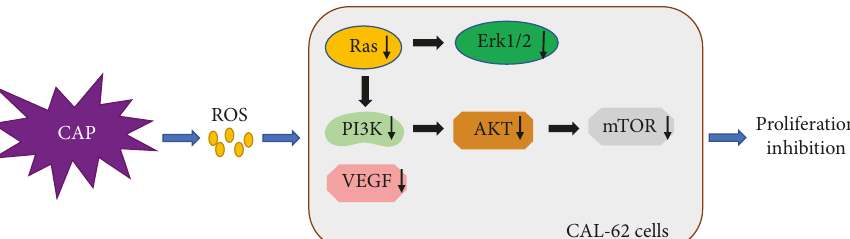
Figure 8: A schematic representation of the mechanism of CAP inhibits the proliferation of CAL-62. ROS produced by CAP can inhibit the expression of PI3K, Akt, mTOR, Ras, Erk1/2, and